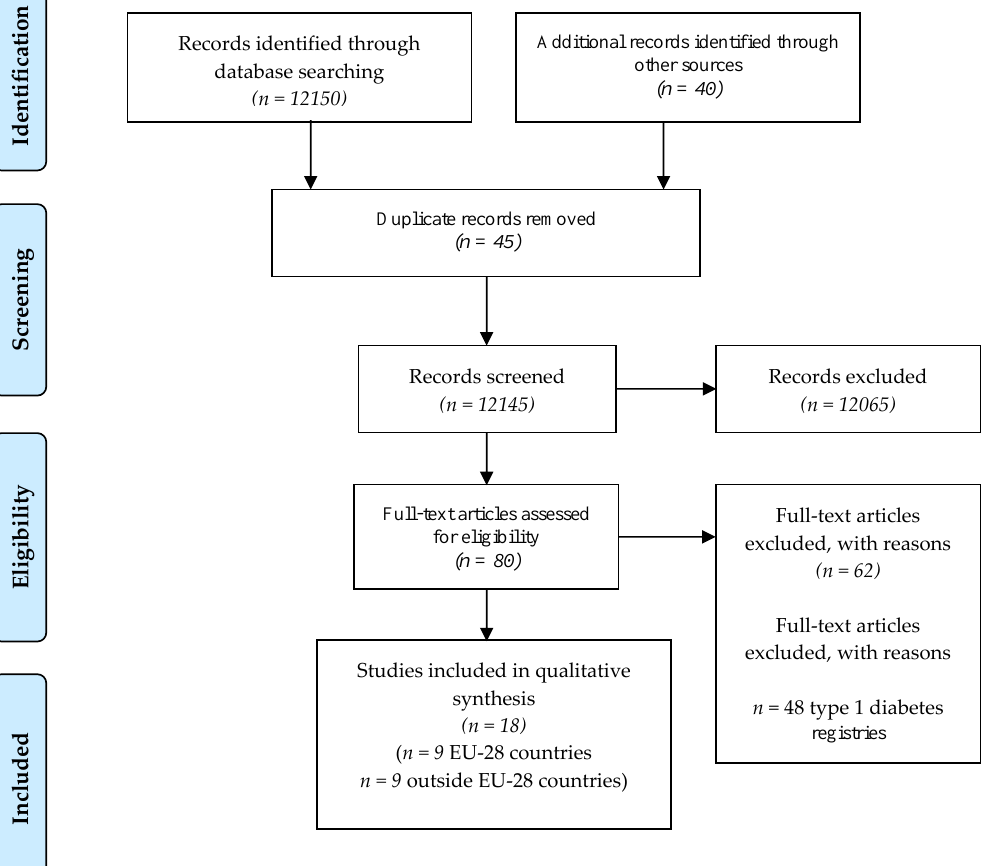
Figure 3. PRISMA flow chart.